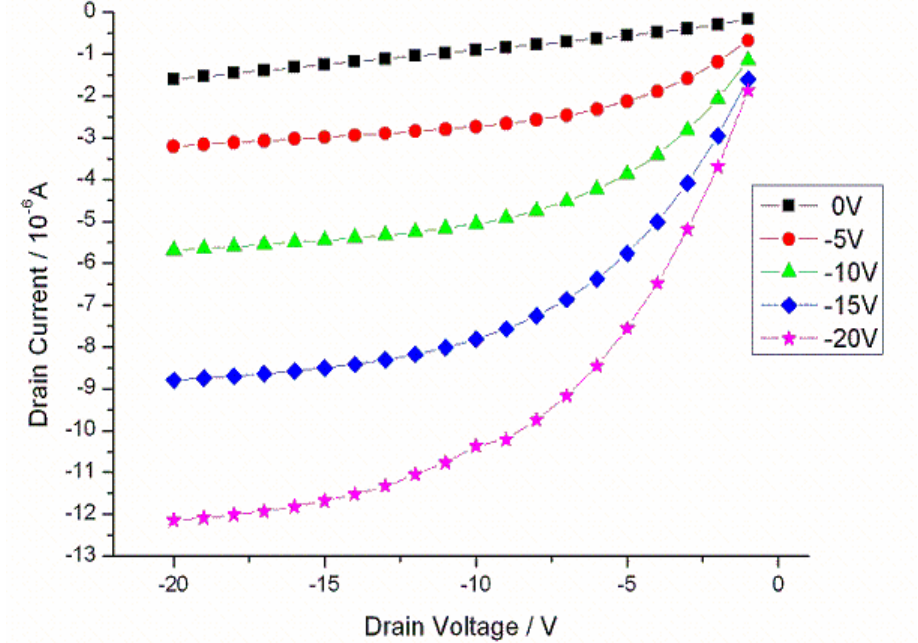
Figure 1. Output characteristics of a transistor with a 20 µm channel length after measurement in ambient conditions. The transistor shows a typical p-type